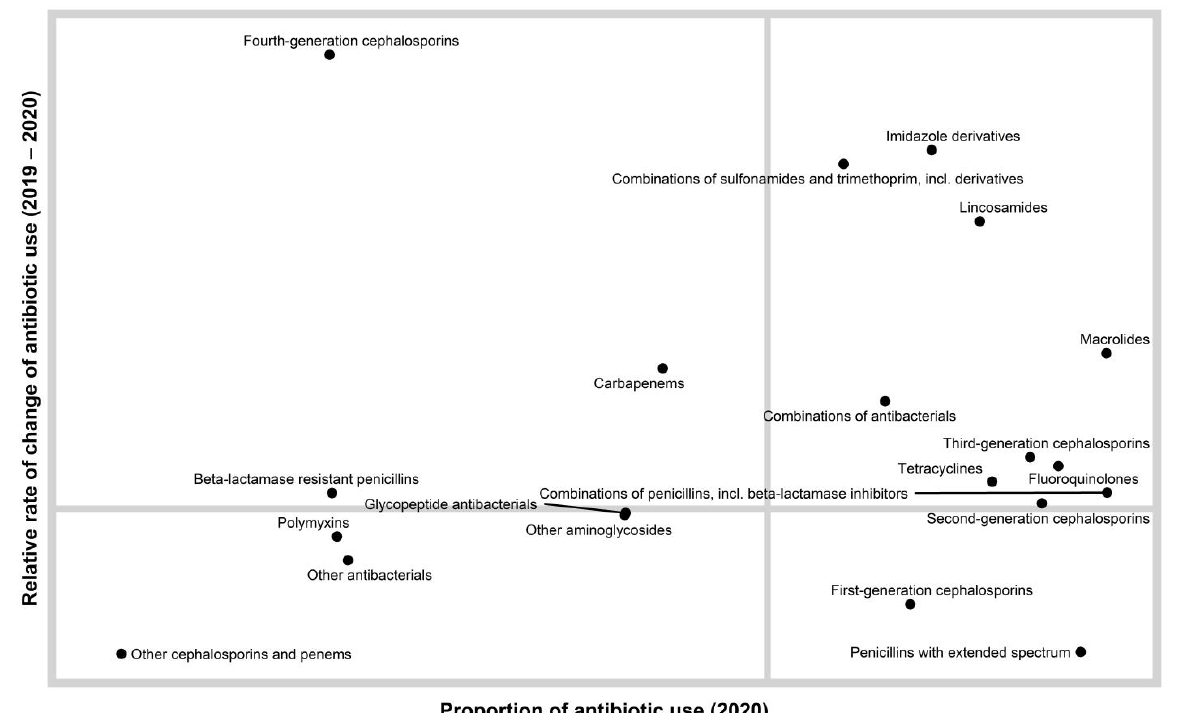
A quadrant chart showing the distribution of antibiotic classes according to relative rate of change of antibiotic use (2019–2020) and the proportion of antibiotic use in 2020 is presented in Figure 1.